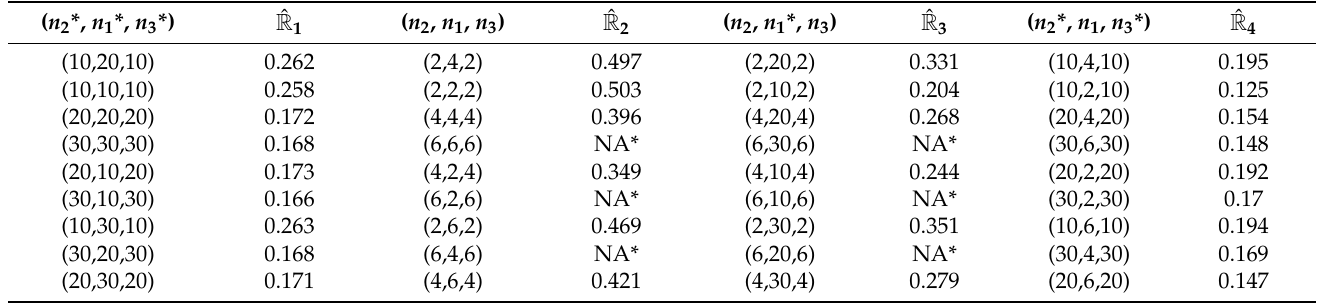
Table 9. SSR estimates of the data sets based on different sampling designs.